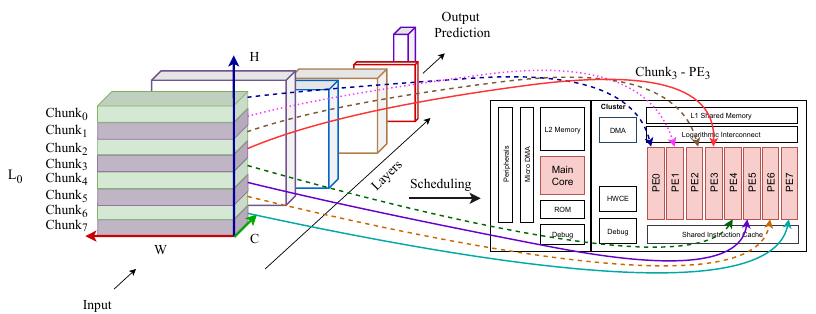
Figure 3. Static scheduling: Neurons assignment in a multiprocessor